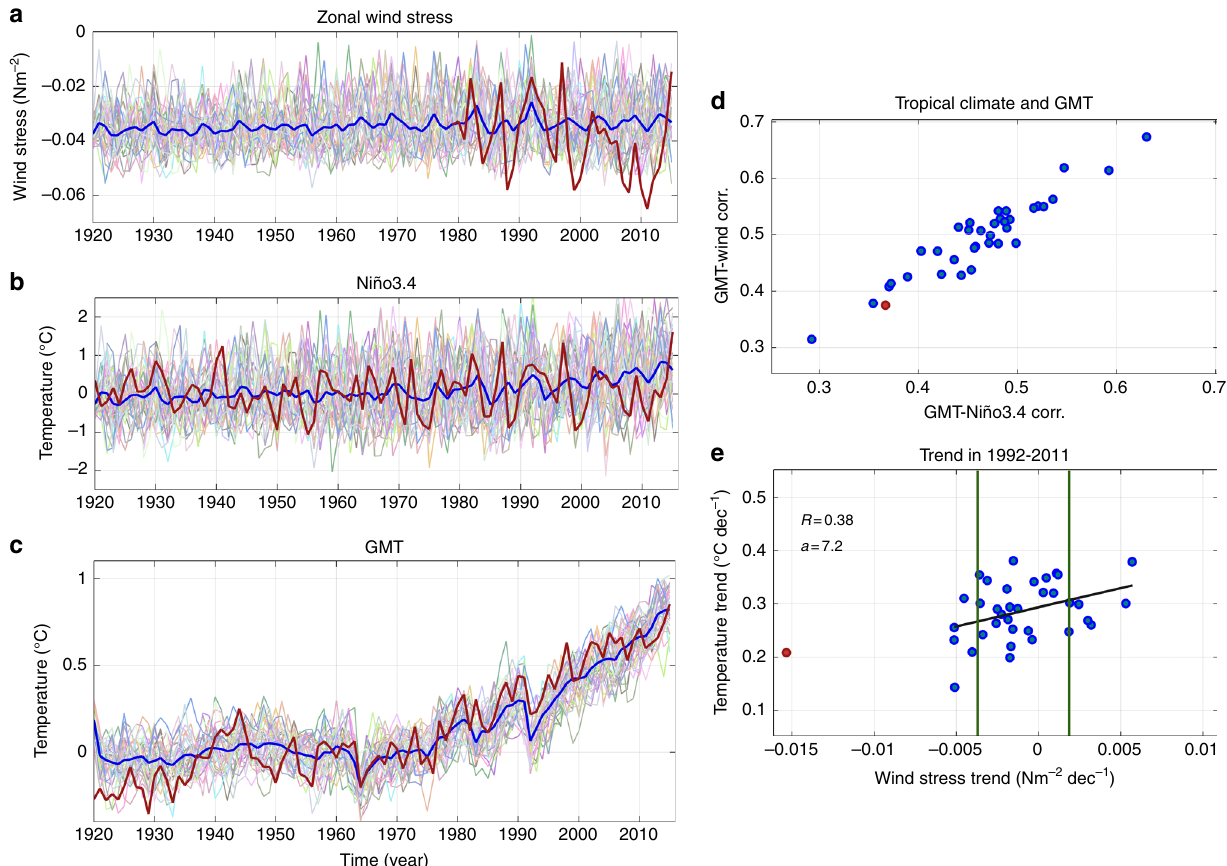
Fig. 2 Observed and simulated Paci fi c trade winds, Niño3.4 index and global mean temperature. Time series of a annual mean equatorial zonal wind stress (areal average over the rectangular box de fi ned in Fig. 1b; Nm − 2 ), b areal averaged sea surface temperature over Niño3.4 region (170°W – 120°W, 5°S – 5°N; Niño3.4 index; °C) and c globally averaged SAT anomaly (°C) from individual members of the CESM-Hind-Proj global warming experiments (thin colored lines). Time series in a and b are computed relative to 1951 – 1980 baseline. The associated ensemble means and observations are shown as thick blue and red lines, respectively. Owing to large observational uncertainty in pre-satellite era 6 , observed wind stress is only shown after 1979. Shown in d is the annual correlation coef fi cient between the GMT and Niño3.4 index (horizontal axis) and between the GMT and the zonal wind stress (vertical axis). e 20-year trends in the zonal wind stress (Nm − 2 /decade) and the GMT (°C/decade) for 1992 – 2011. In d and e , blue (red) circles denote the individual ensemble members (observation). The vertical solid lines in e indicate the mean ± Std of the trend in the wind stress and black solid lines denote the regression lines between GMT and wind stress trends. Also shown near the top-left corner of e are the correlation between the wind stress and GMT trends ( R ) and the slope of the regression line ( a ). Please note that in d , the linear trend was subtracted from all data sets prior to computing the